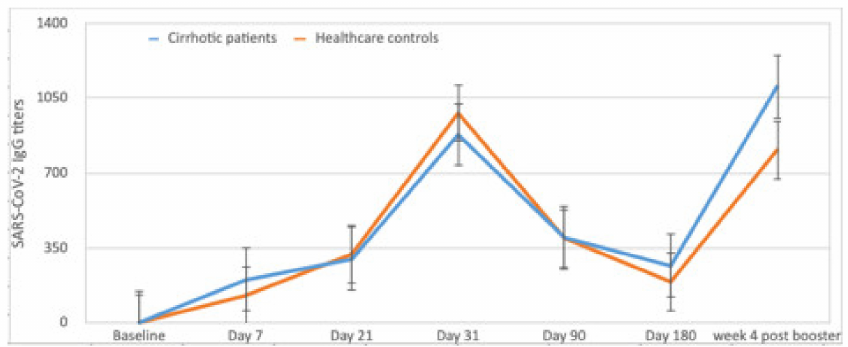
Figure 1. Longitudinal titers of SARS-CoV-2 IgG at the different time points in unexperienced cirrhotics and in HW. BAU/mL levels in patients with results higher than the positivity threshold are reported in y axis. Dose 1 was administered between 1 March and 15 March, dose 2 between 1 April and 15 April, dose 3 was administered 24 ± 2 weeks after the first